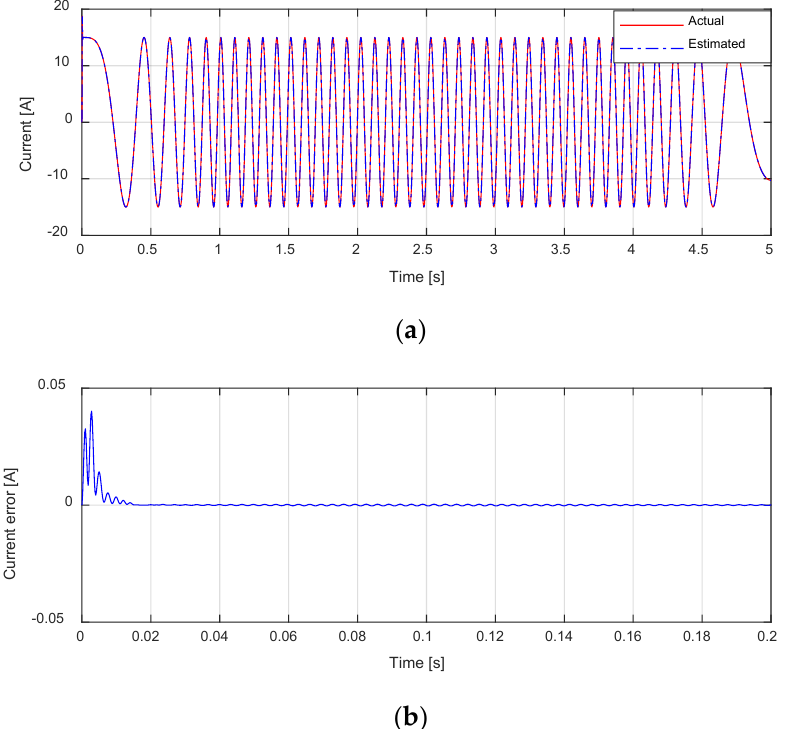
Figure 5. Estimation performance of yaw. ( a ) Estimation performance of θ yaw and ˆ θ yaw . ( b ) (cid:101) θ yaw estimation error.